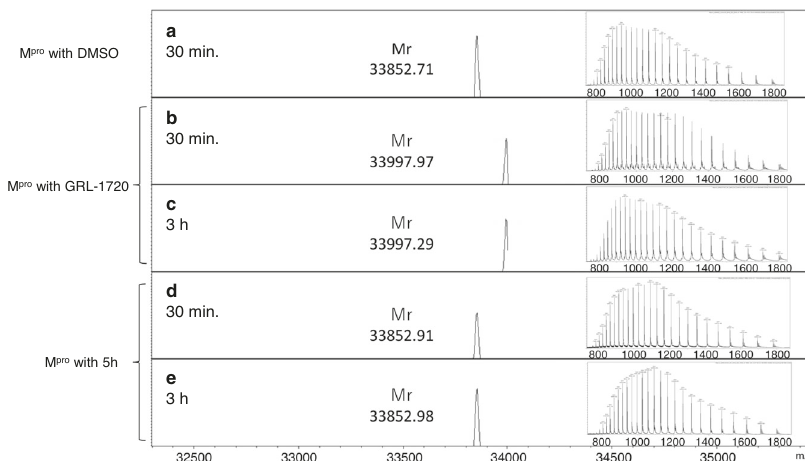
Fig. 7 Mass spectrometry analysis of apoM pro , GRL-1720- and 5h-treated Mpro. Deconvoluted mass spectra of 10 µ M apoM pro treated with DMSO ( a ), GRL-1720 ( b and c ) and 5h ( d and e ) are shown for 30 min and 3 h, respectively. The insets show the molecular ion pro fi les for apoM pro , and GRL-1720- and 5h-treated M pro . The theoretical molecular mass is 33,853.41 Da (average mass) for apoM pro and 33,998.56 Da (average mass) for the 1 H -indpline-4- carbonyl group-binding form of M pro